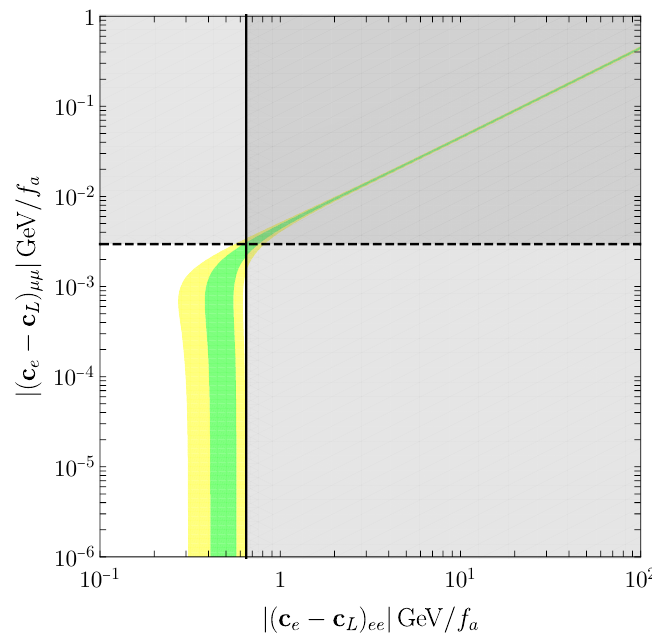
Figure 14. Very light ALP ( m a ≤ 2 m µ ). Parameter space ( c e − c L ) ee /f a vs. ( c e − c L ) µµ /f a that solves the R anomaly assuming ( c + c ) = 10 − 5 GeV − 1 . The green (yellow) regions corre- K Q d sb /f a spond to the allowed parameter space at 1 σ ( 2 σ ). In grey are represented the experimental bounds from B → Kµ + µ − (enclosed by the dashed line) and B → Ke + e − (enclosed by the solid